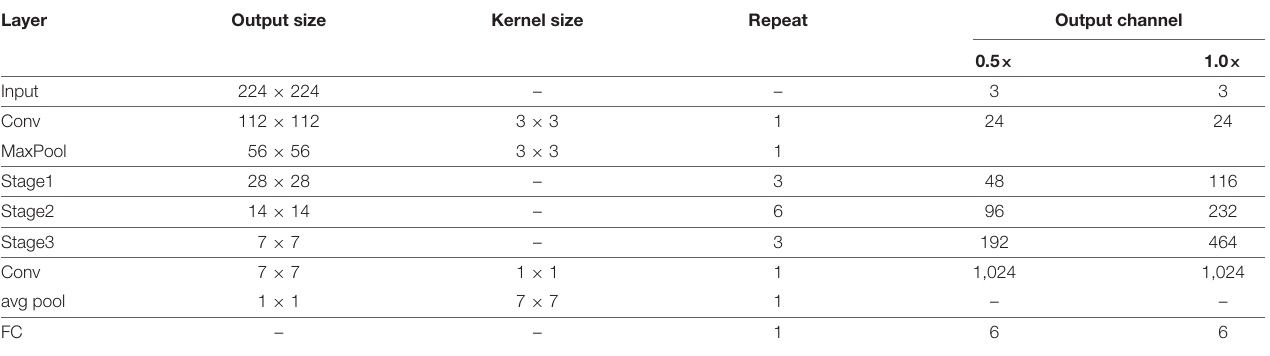
TABLE 2 | Detailed structural information of ECA-SNet.